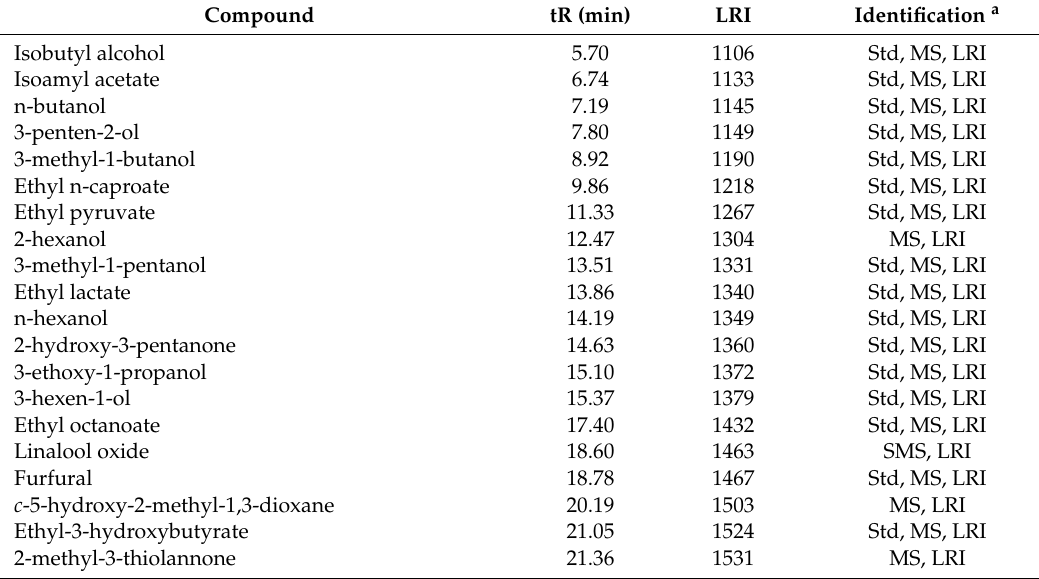
Table 5. List of identified compounds, HMF = 5-hydroxymethylfurfural. a Identification assignment: Std = comparing mass spectra, linear retention index (LRI) and retention times with pure compounds, MS = by comparing mass spectra with NIST 08 and Wiley 7 spectral database, LRI = matching LRI on comparable polar columns (taken from the following publicly available databases: [39,40]).